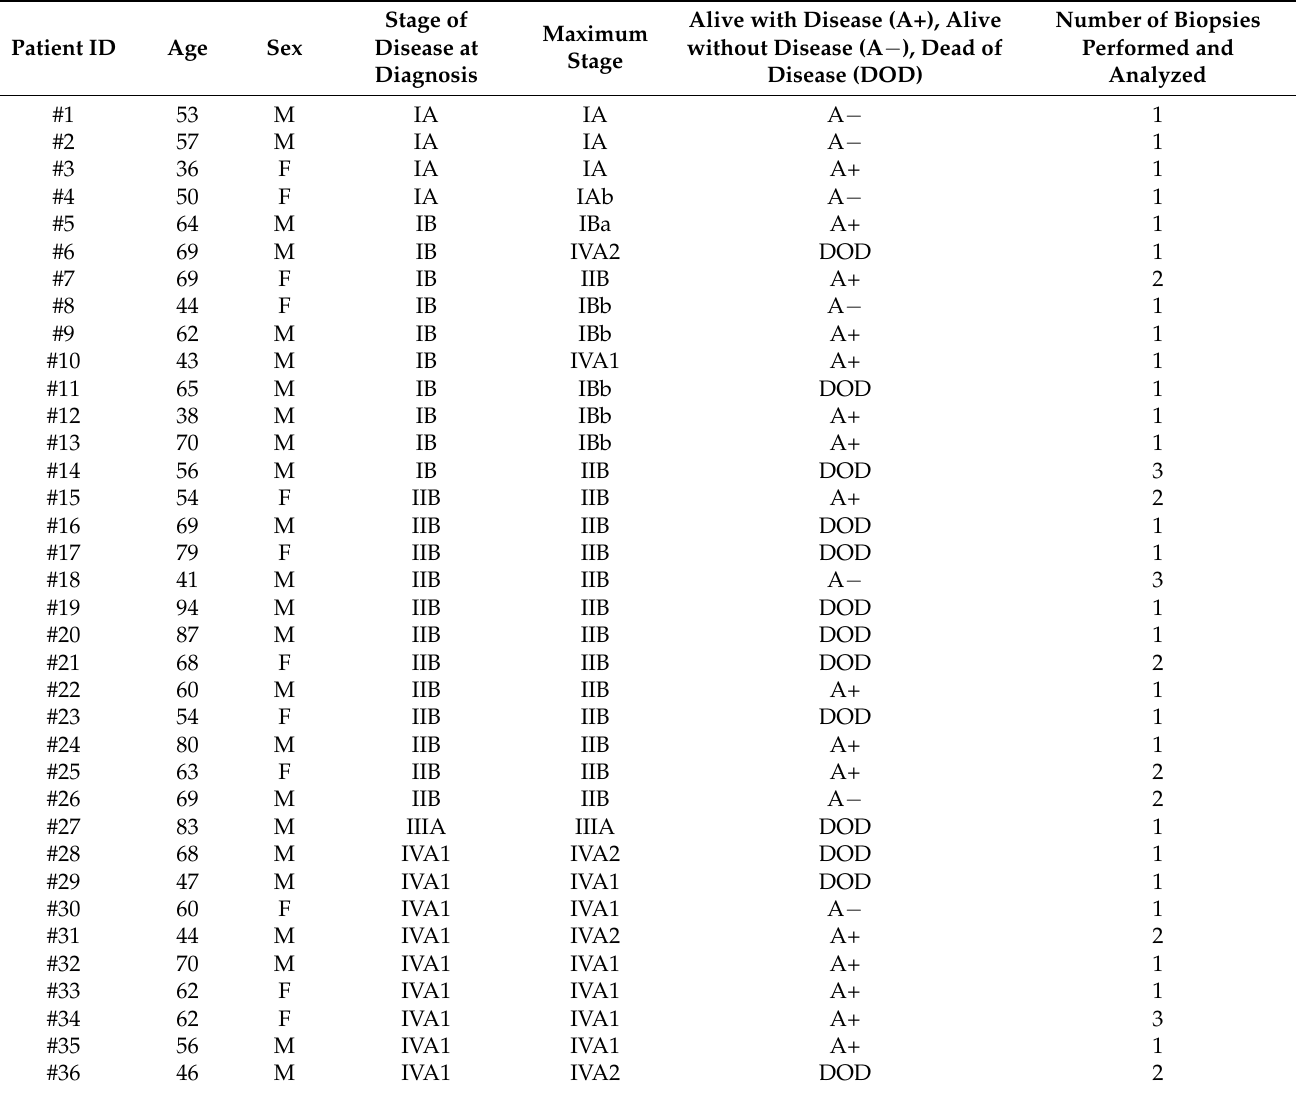
Table 1. Clinical information of patients affected by